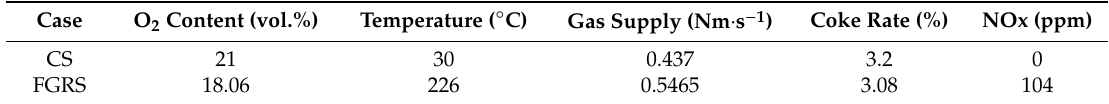
Table 6. Simulation